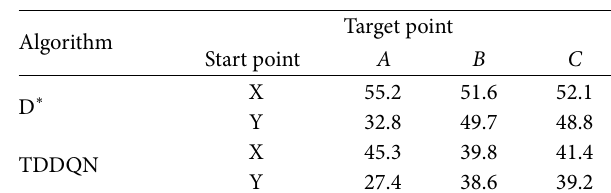
Figure 14: The agent moving on a dynamic slope ground. Table 2: Comparison of TDDQN and